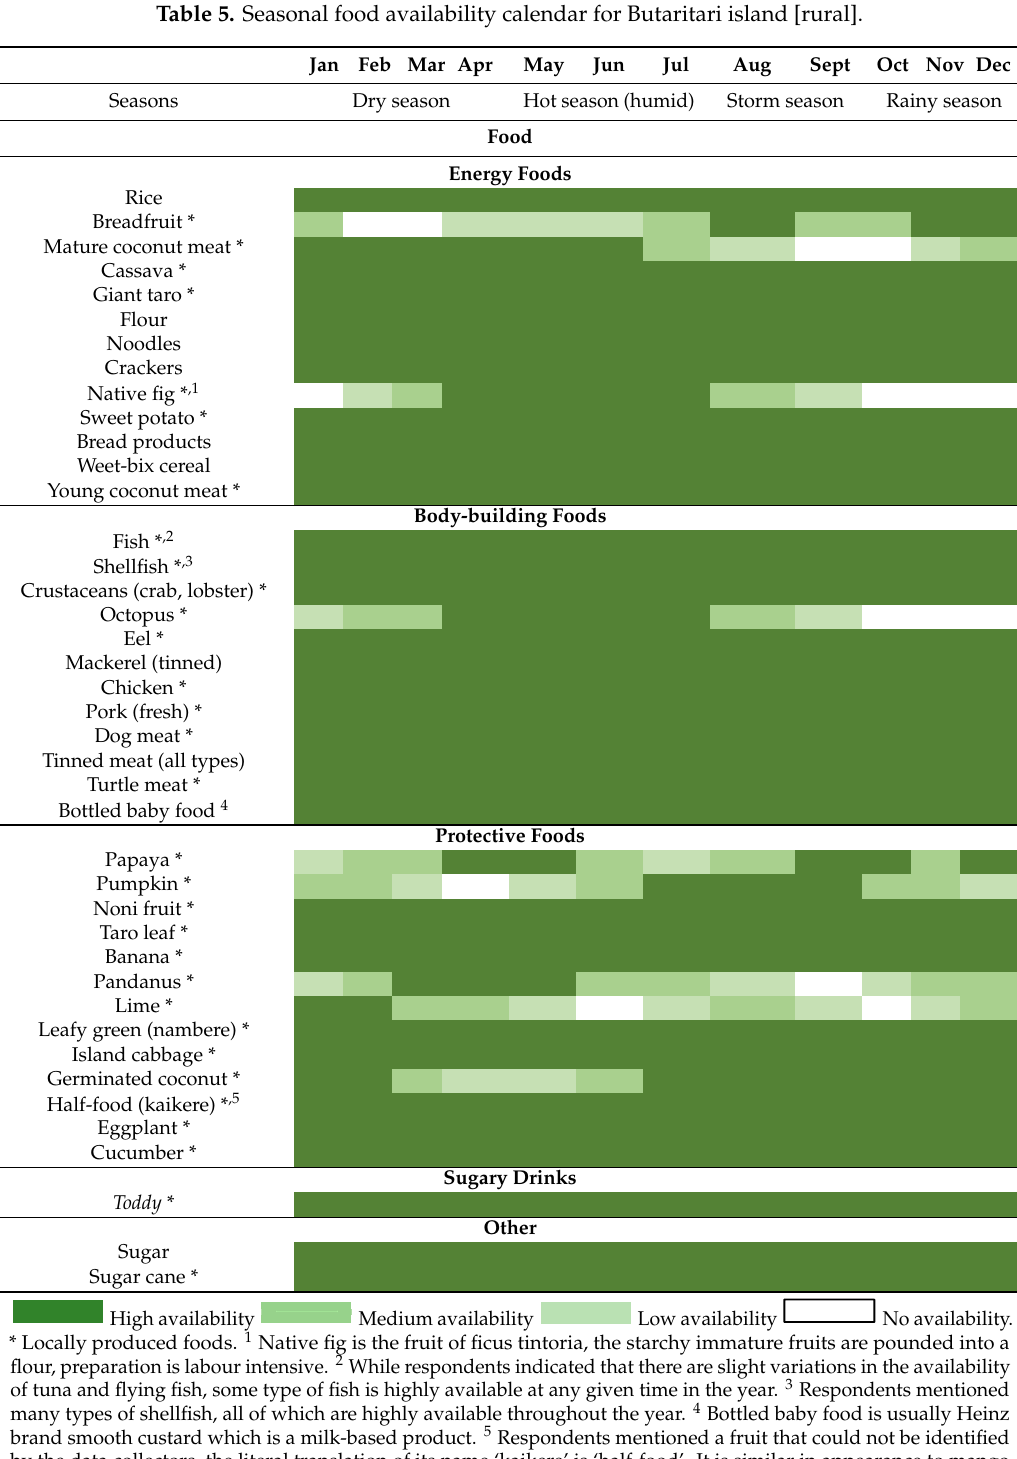
Table 5. Seasonal food availability calendar for Butaritari island [rural].